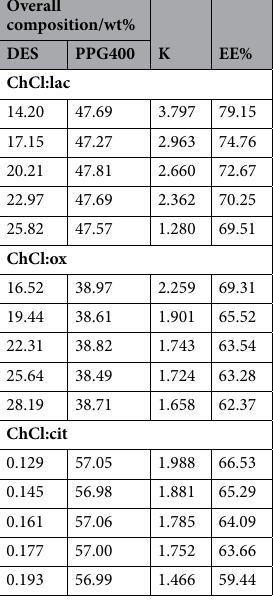
Table 2. Values of partitioning coefficients, K , and extraction efficiency, EE %, of 5-HMF for the systems {PPG400 + DES + H 2 O} at 298.15 K and atmospheric pressure (≈ 85